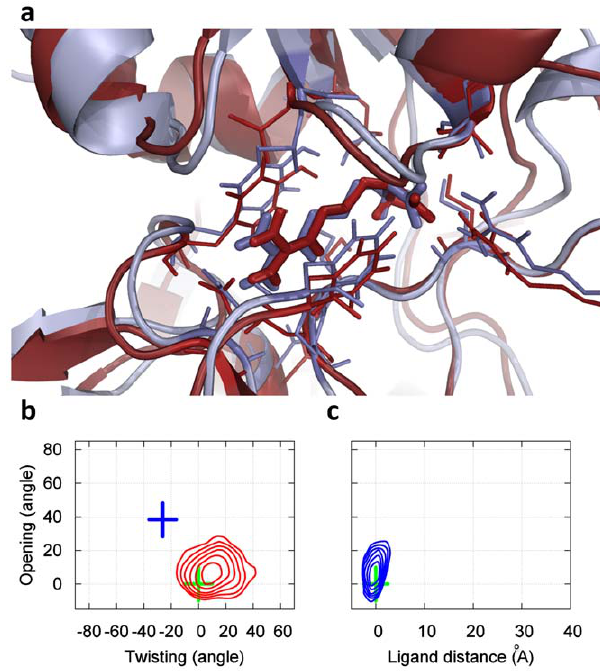
Figure 2. The bound state of our MSM for LAO binding (which is also the most populated state, having an equilibrium population of 74.9%). (a) A snapshot from our simulations (red) achieves a 1.2 A˚ RMSD to the X-ray bound state (blue, PDB ID: 1LAF). The RMSD is computed from the protein C a atoms that are within 8 A˚ to the center of mass of the ligand in the X-ray bound state (Residues included the RMSD is 1.8 A˚. (b) Free energy plot of the protein opening angle versus twisting angle. The bin size is (5 u , 5 u ), and the interval between two adjacent contour levels is 0.5 KT. The green and blue crosses correspond to X-ray structures of the bound and apo conformations respectively. (c) Free energy plot of the opening angle versus the distance between the ligand and the binding site. The bin size is (1.5 A˚, 5 u ), and interval between contour levels is 0.5 KT.